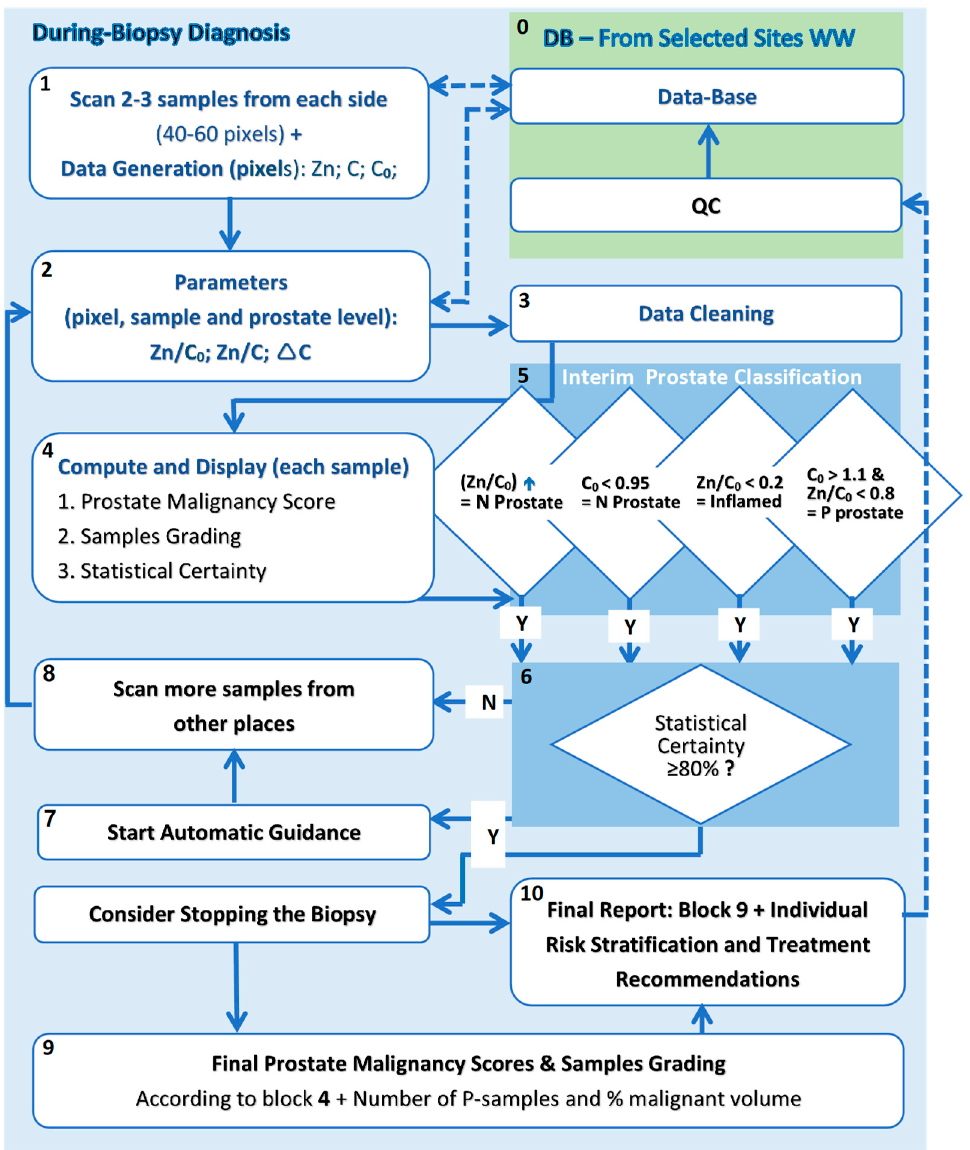
Figure 6. Clinical flowchart—malignancy scoring, sample grading/scoring and guidance during biopsy.